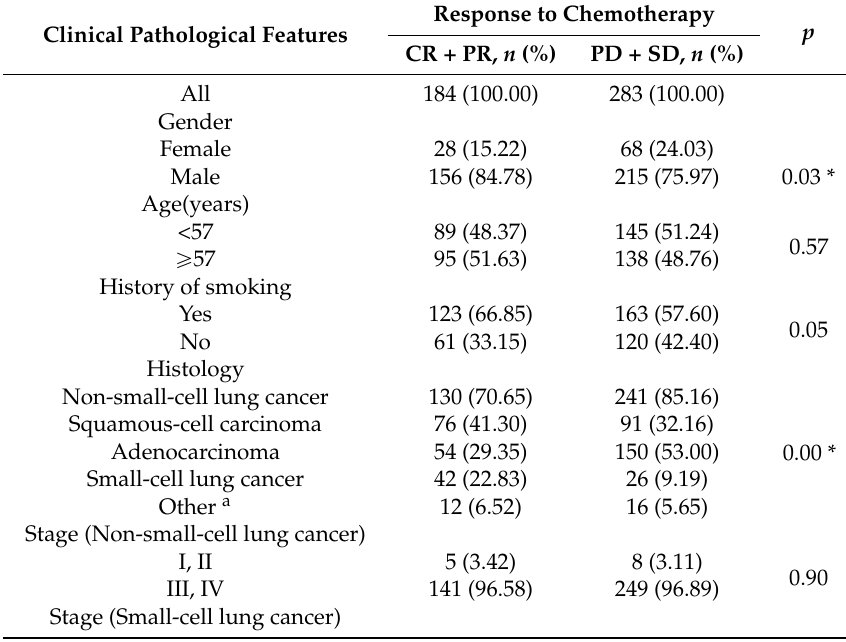
Table 2. Association of chemotherapy responses with clinical pathologic